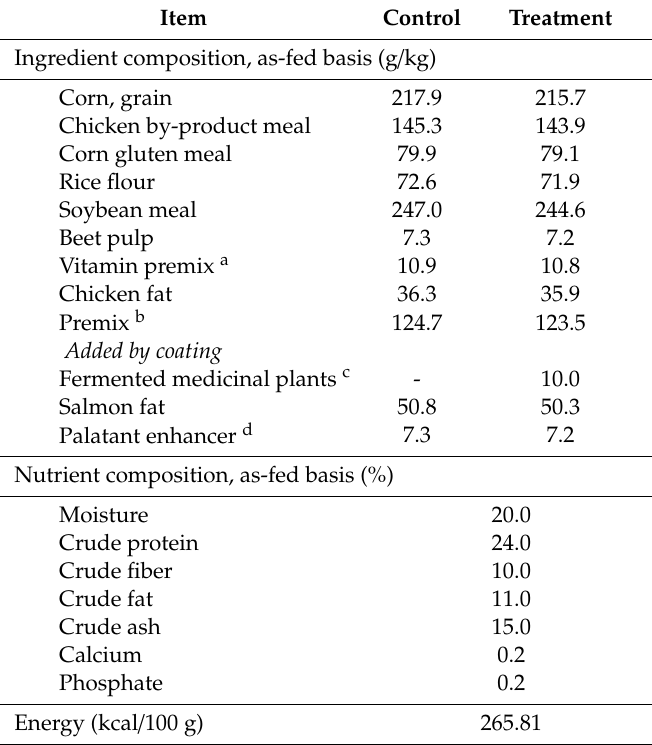
Table 1. Ingredients and chemical composition of experimental